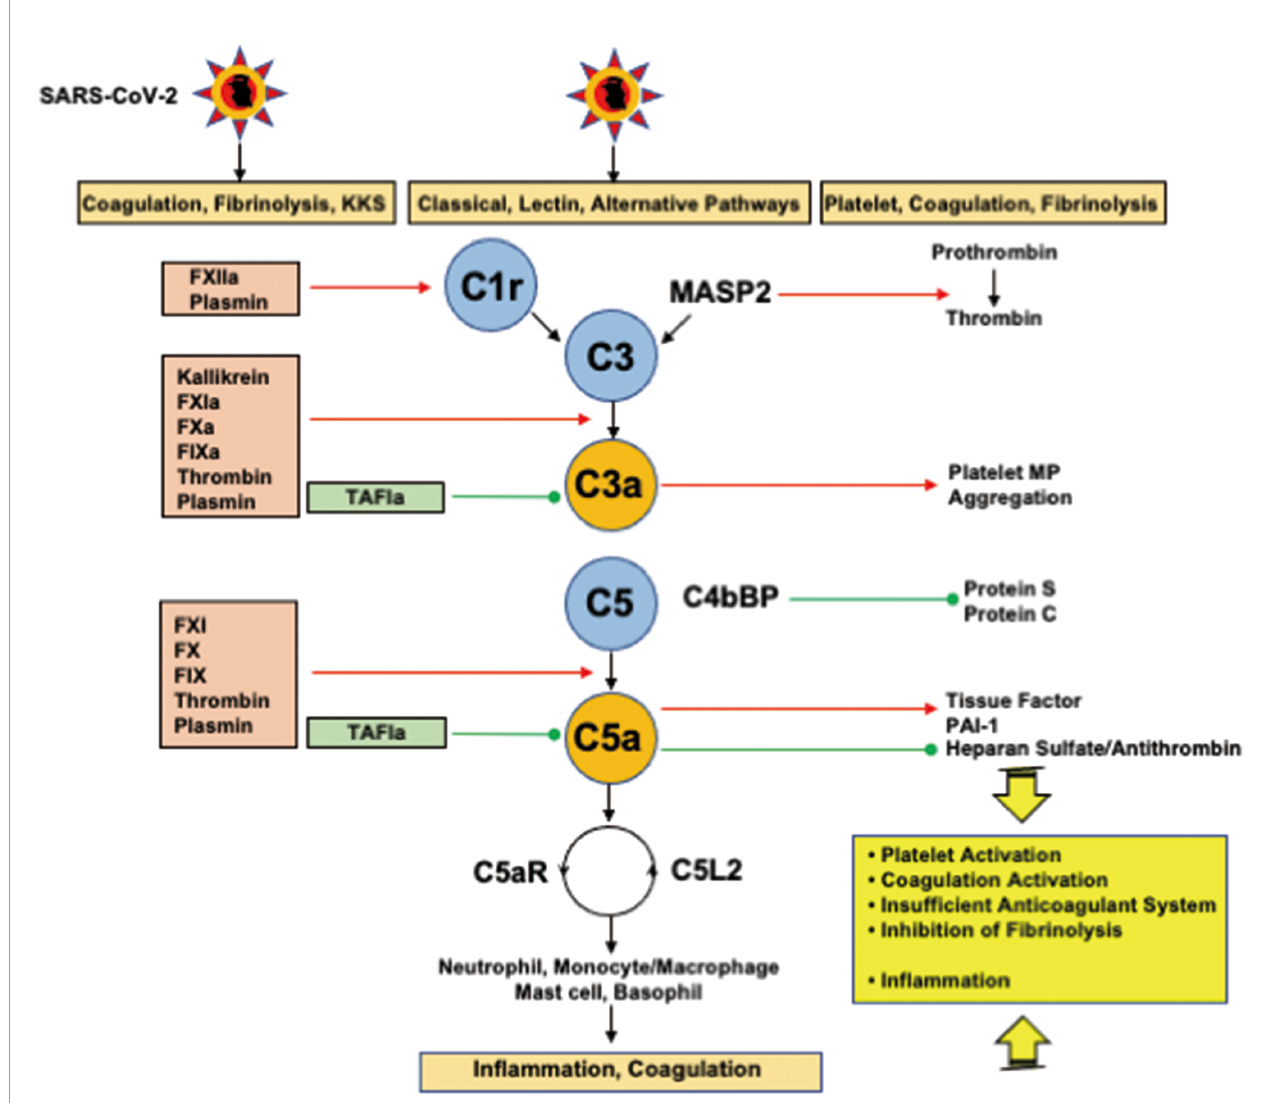
FIGURE 4 | Interplays among coagulation, fi brinolysis, complement pathways, and in fl ammation. FXIIa and plasmin activate C1r to initiate the classical pathway. In addition to kallikrein, FXIa, FXa, FIXa, thrombin, and plasmin cleave C3 and C5 to generate C3a and C5a. Importantly, kallikrein, thrombin, and plasmin are able to directly activate C3, and thrombin can generate C5a without the participation of C3. TAFIa is the only molecule that blocks C3a and C5a. MASP2 and MAC (not shown in the fi gure) cleave prothrombin into thrombin. C3a generates platelet procoagulant microparticles and induce platelet aggregation. C5a expresses tissue factor and PAI-1 on neutrophils and mast cells, respectively through C5aR, and inhibits the antithrombin-mediated anticoagulation pathway through the shedding of glycocalyx heparan sulfate. Complex formation between C4bBP and protein S impairs the functional property of protein S, a cofactor of protein C, resulting in a decrease in the conversion of protein C to activated protein C. C5a fi nally induces in fl ammation via in fl ammatory cells through C5aR and C5L2. These mutual actions of the serine protease network contribute to in fl ammation and thrombus formation at the site of infection, if the infection is suf fi ciently severe, disseminating to the systemic circulation, and DIC associated with SIRS ensues. C5aR, C5a receptor; C5L2, C5-like receptor2; C4bBP, C4b binding protein; DIC, disseminated intravascular coagulation; MAC, membrane attack complex; MASP, mannose-binding lectin-associated serine protease 2; PAI-1, plasminogen activator inhibitor-1; SARS-CoV-2, severe acute respiratory syndrome coronavirus 2; SIRS, systemic in fl ammatory response syndrome; TAFIa, activated thrombin-activatable fi brinolysis inhibitor. Red arrows indicate activation and green lines with circle-head indicate